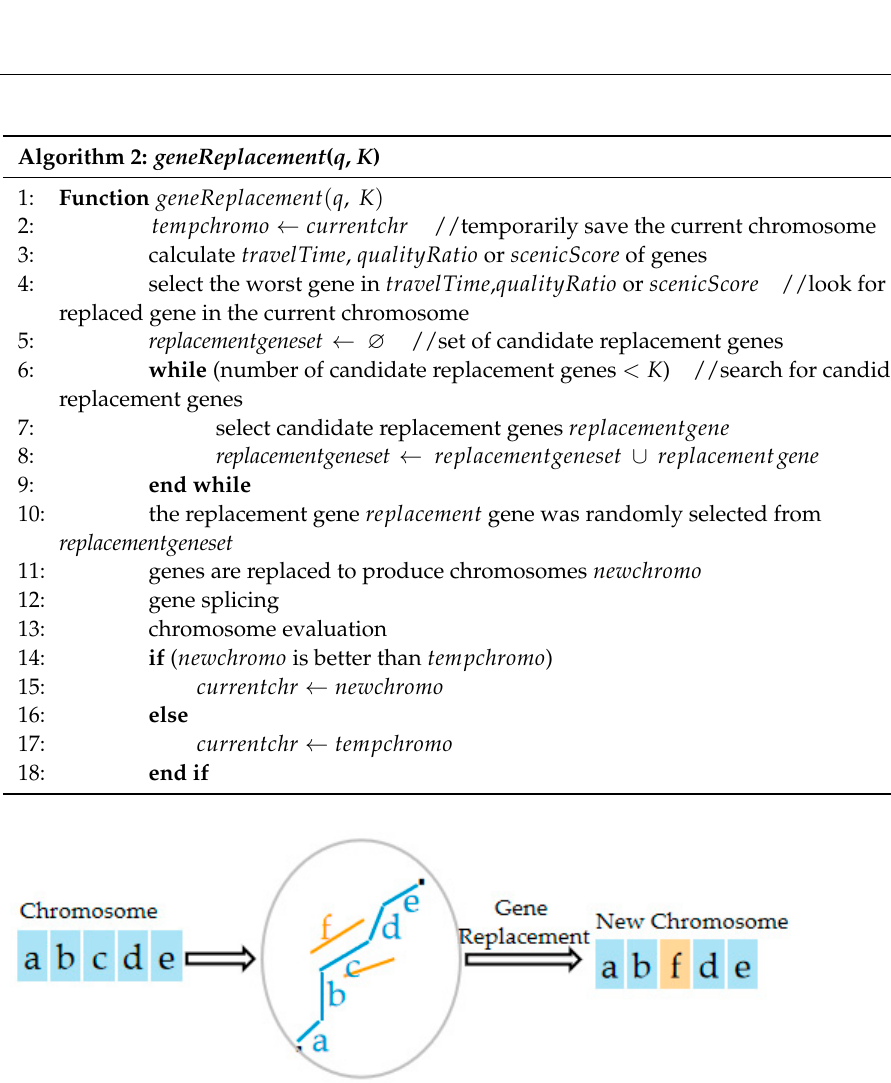
Table 1. Introduction to road network dataset.